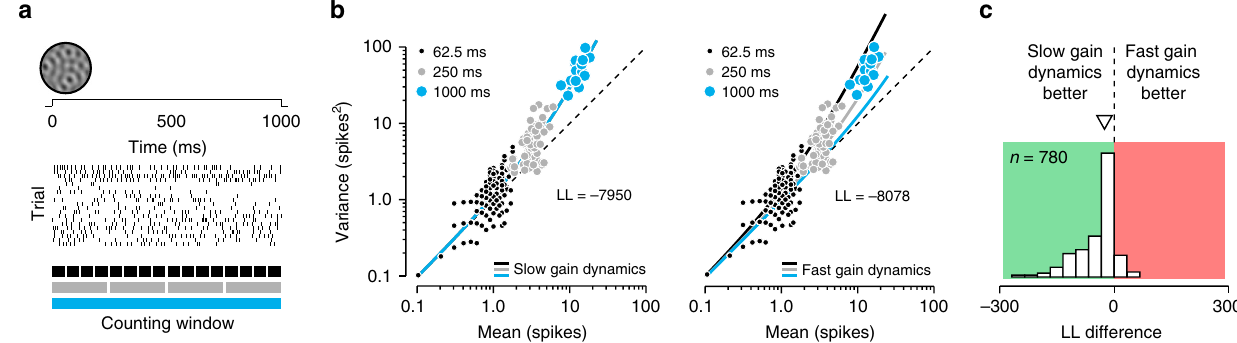
Fig. 6 Comparison of models with slow and fast gain dynamics. a For every unique stimulus condition, we computed responses using fi ve different spike- count windows, spanning 62.5, 125, 250, 500, and 1000ms respectively. b Variance-to-mean relation for one stimulus family for an example V1 neuron. Responses are shown for three different counting windows: 62.5 ms (black points), 250 ms (gray points), and 1000 ms (blue points). We fi t two models to these data: one with slow gain dynamics (left panel), and one with fast gain dynamics (right panel). Slow gain dynamics predict the same variance-to-mean relationship for different counting window sizes. Fast gain dynamics predict that the variance-to-mean relationship becomes more linear with longer counting windows. We measured goodness-of- fi t by computing the log likelihood of the data under each model, yielding a value of − 7950 for the slow- dynamics model, and of − 8078 for the fast-dynamics model. c Distribution of the difference in log likelihood under both models for a population of V1 and V2 neurons.